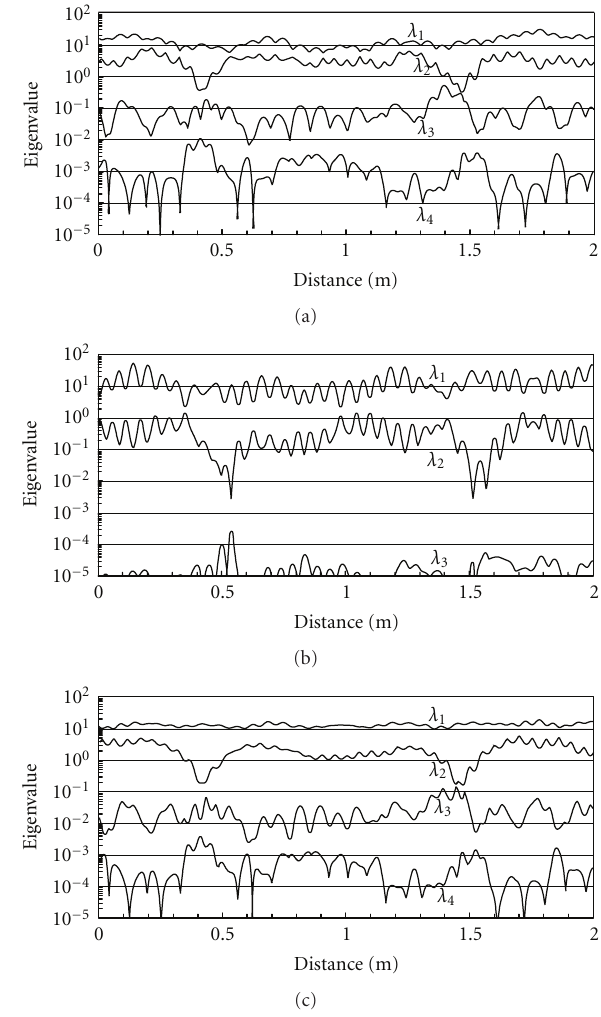
Figure 7: Example of eigenvalue variation with movement (4 × 4 MIMO, uniform distribution). (a) NLOS ( ρ = 0 . 2). (b) NLOS ( ρ = 0 . 9). (c) LOS ( K = 5[dB], ρ = 0 .